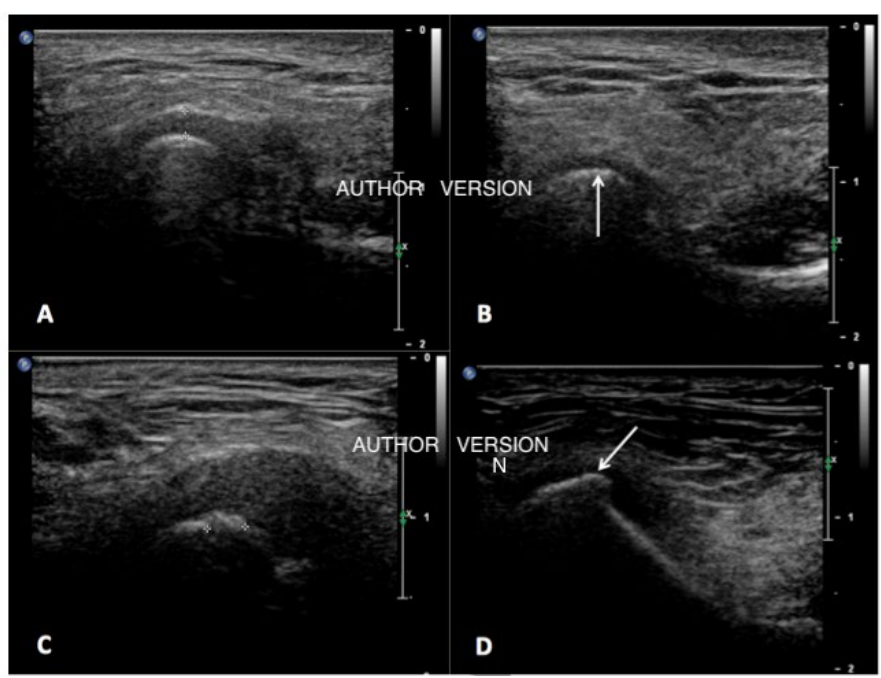
Figure 2. Different stages of condylar head articular surface degeneration visible on ultrasound pictures. Normal smooth surface of the condylar head ( A ). Subchondral sclerotic changes-typical for overload (arrow) ( B ). Cartilage destruction with penetration of productive changes (marked by clippers) ( C ). Osteophyte formation (arrow) ( D ).